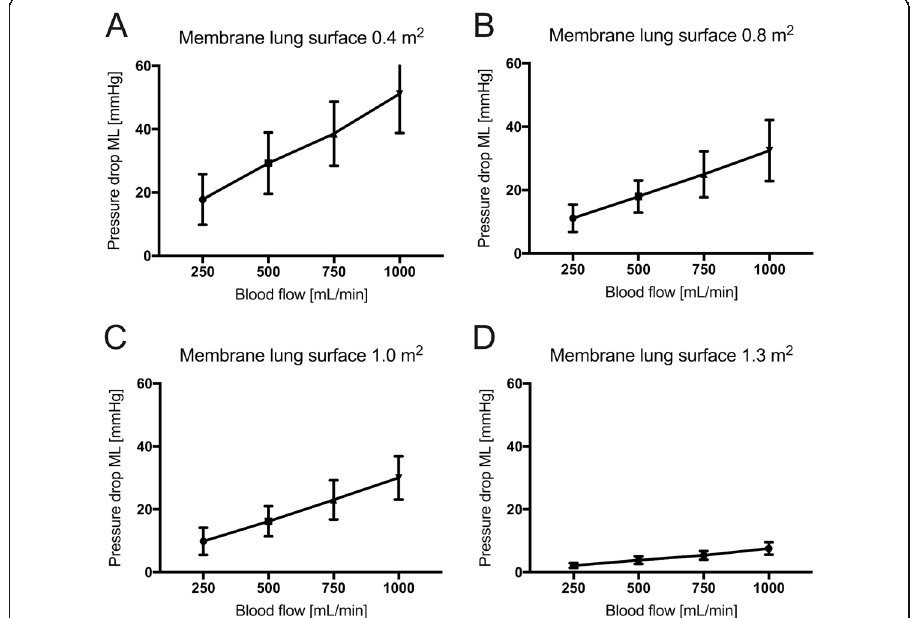
Fig. 5 Pressure drop across the membrane lung depending on blood flow. Membrane lung surface ranges from 0.4 m 2 ( a ), 0.8 m 2 ( b ), 1.0 m 2 ( c ) to 1.3 m2 ( d ) with a sweep gas flow of 8 L O 2 /min. Blood flow was titrated from 250 to 1000 ml/min. Each data point represents the mean and standard deviation of seven